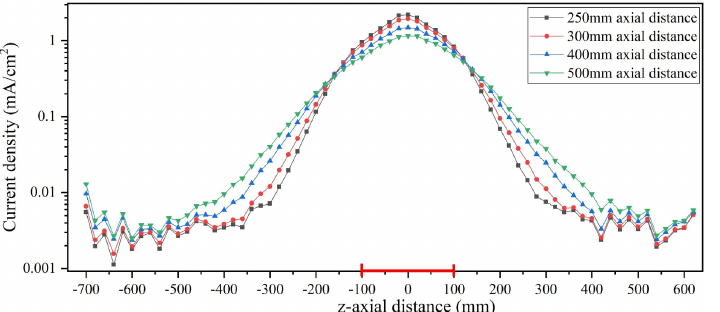
Figure 11. Current density measured by the Faraday probe array for the LIPS-200 ion thruster [46]. The red line refers to the diameter of thruster exit plane.